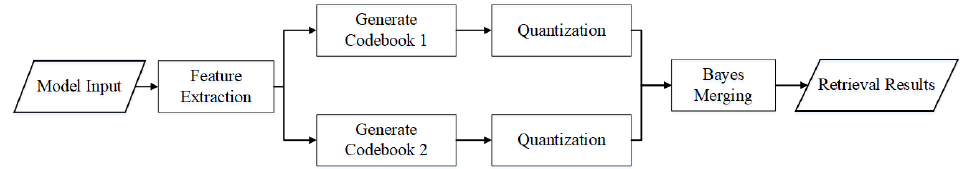
Figure 2. The flowchart of the algorithm.